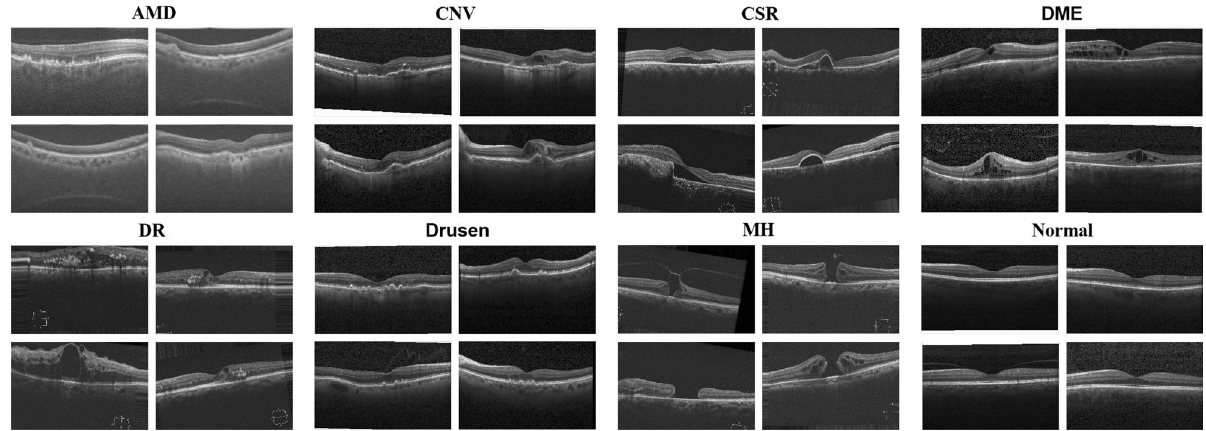
Figure 1. Examples of OCT images in eight classes, including AMD, CNV, CSR, DME, DR, drusen, MH and